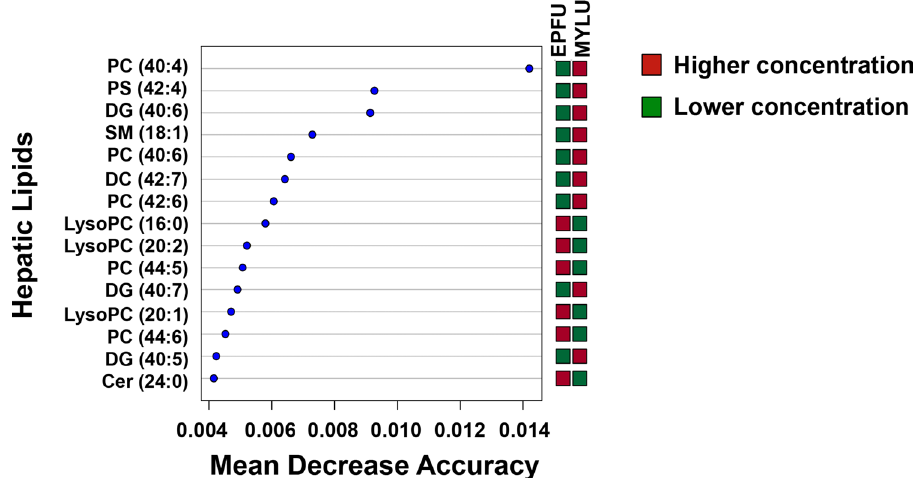
Figure 1. Variable importance in the Random Forests analysis of hepatic lipid concentrations between hibernating Myotis lucifugus (MYLU) and Eptesicus fuscus (EPFU). SM sphingomyelin, DG diacylglyceride, Cer